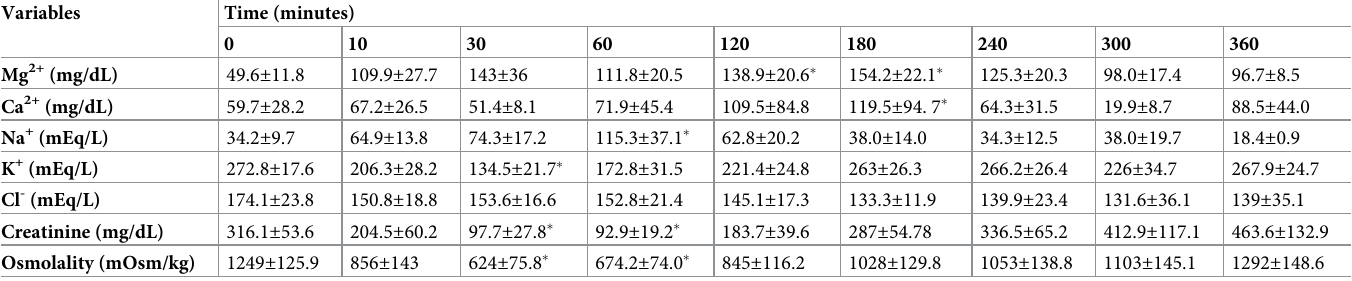
Table 2. Urine Mg 2+ , Ca 2+ , Na + , K + , Cl - , and creatinine concentrations and urine osmolality following IV administration of MgSO 4 (60 mg/kg) in healthy horses.